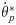
Block diagram of the improved model including a flapping wing force feedback control based on the vertical optic flow (green) and a pitch rate closed-loop control based on the absolute pitch measurement (purple).(A) Diagram of the model including a feed-back control loop based on ωZRfly accounting for the force produced by flapping wings and a feed-back control loop based on θp accounting for the control of θ˙p*. (B) Averaged (large solid line) and 10 samples (thin solid line) height measured during 150 simulations of free fall conducted with the new model. Model simulations results are presented in color (wingbeat triggering time of 75-100ms are shown in green, 100-125ms in blue and 125-150ms in red) and experimental data appears in grey. Inset shows the percentage of cumulated crash during 150 model simulations lasting 3 seconds. (C) Averaged heave (top panel) and surge speed (bottom panel) measured during the 150 simulations of free fall conducted with the new model. Model simulations are presented in dotted lines and experimental data in solid lines. Results are split in the three wingbeat initiation groups: 75-100ms are shown in green, 100-125ms in blue and 125-150ms in red.